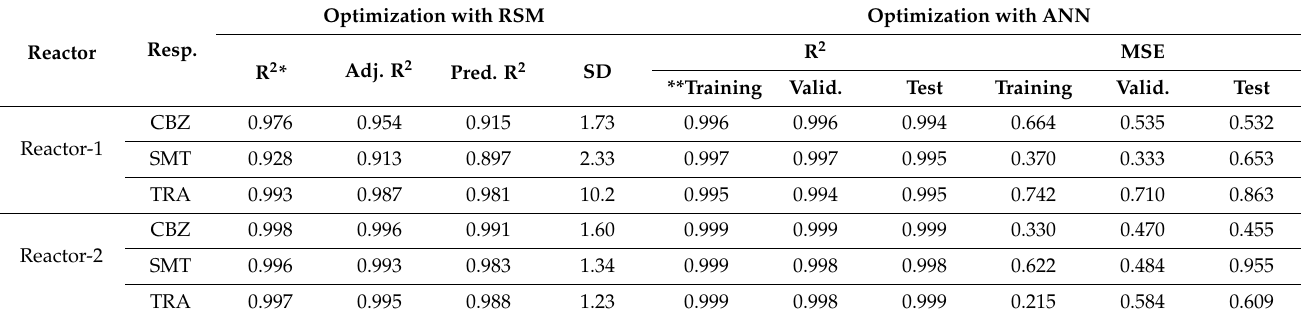
Table 4. Statistical analysis results for the response parameters in RSM and